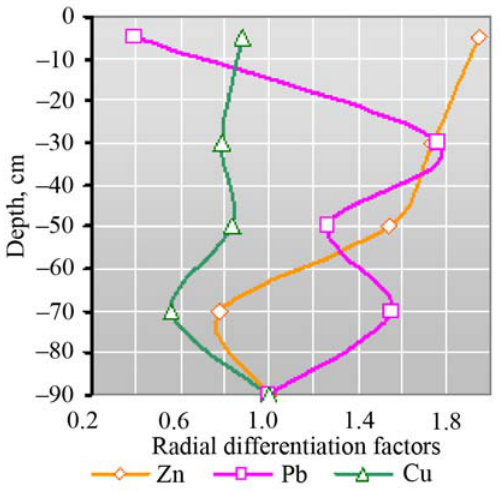
Fig. 8. Heavy metals in second grassland soil profile